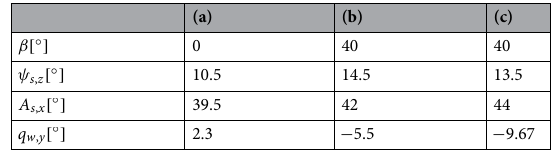
Table 1. Parameters for the three representative limit cycles studied in more detail, corresponding to one unstable and two stable flight regimes, respectively, at a forward flight velocity of 14 ms − 1